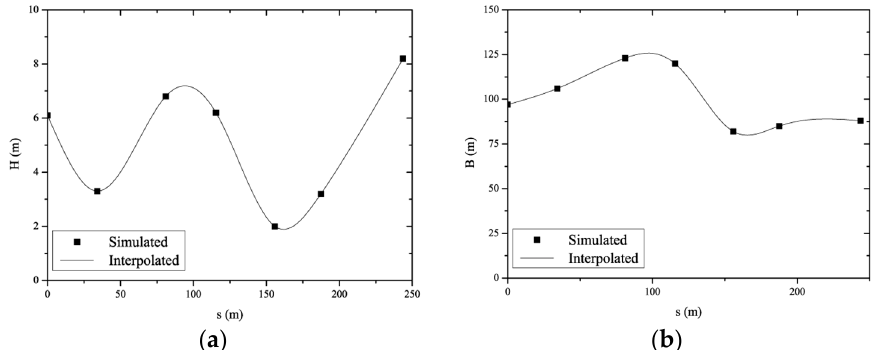
Figure 9. Maximum water height H ( a ); and channel width B ( b ) against the s ‐ coordinate for the 7 river cross sections of the narrow bending meander centered on section O2 ‐ P2, as indicated in Figure 6a.